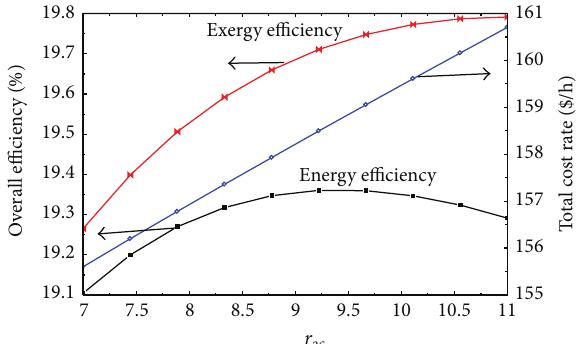
Figure 7: The impact of the compressor pressure ratio on the cost rate and efficiencies.